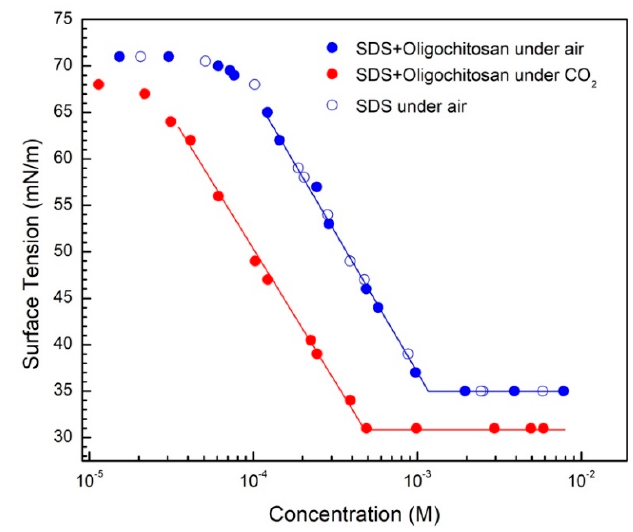
Figure 1. Conductivity of aqueous solution of oligochitosan (0.2 wt.%) against time during two cycles of sparging CO 2 and N 2 at 25 ± 0.5 °C.